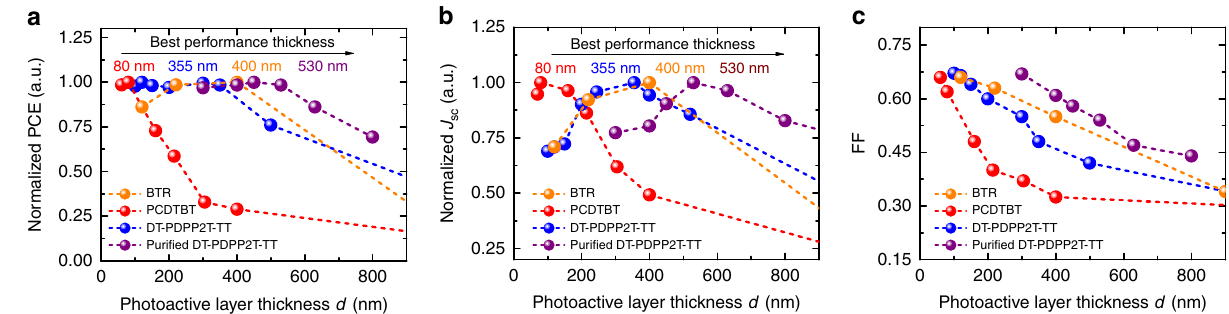
Fig. 1 Thickness-dependent device performance. PCDTBT:PC 71 BM, original DT-PDPP2T-TT:PC 71 BM, BTR:PC 71 BM and puri fi ed DT-PDPP2T-TT:PC 71 BM are compared with thickness-dependent device performance. a Normalised PCE as a function of photoactive layer thickness, labelled thickness is assigned the best performing thickness. b Normalised J sc as a function of photoactive layer thickness, labelled thickness is associated with the best performing thickness. c Normalised FFs as a function of photoactive 355 nm for DT-PDPP2T-TT as donor polymer, 400 nm for BTR and 530 nm for puri fi ed DT-PDPP2T-TT. All devices show a